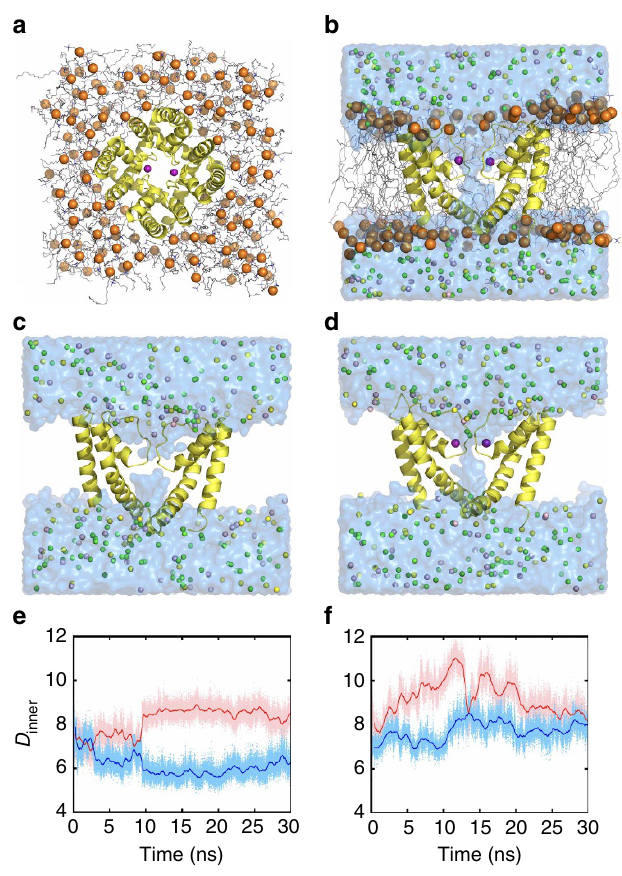
Figure 7 | MD simulations. ( a ) The top view and ( b ) the side view of the two Ca 2 þ bound membrane-channel system before simulations using the Drude polarizable force field. After 30ns simulation, the pore closes in the system ( c ) without any Ca 2 þ at the S Ca site, whereas the selectivity filter pore remains open and permeable to water in the system ( d ) with two Ca 2 þ bound at the S Ca site. The NaKTs channel is shown in yellow cartoon presentation with the front and back subunits hidden in ( b – d ) for the sake of clarity. POPC lipids are shown as grey lines with their phosphates in orange spheres. Ca 2 þ ions are indicated by purple spheres. The other ions including K þ (light pink), Na þ (yellow) and Cl (cid:2) (green) are shown as well. Surface rendering (marine) is used to show the water accessible regions in the system. The molecular presentation is created using PyMOL. ( e , f ) show the time series of D inner in the zero and two S Ca Ca 2 þ systems with (cid:2) 500mV TM potential, respectively. The lighter-coloured points are instantaneous values of D inner and the lines show the running averages. The two D inner in one tetramer channel are distinguished by different